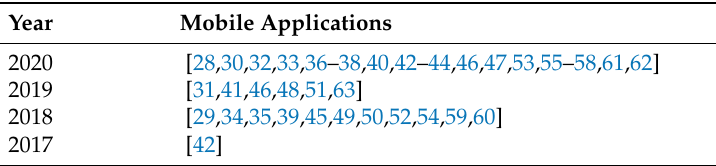
Table 4. Distribution of mobile application by last update.